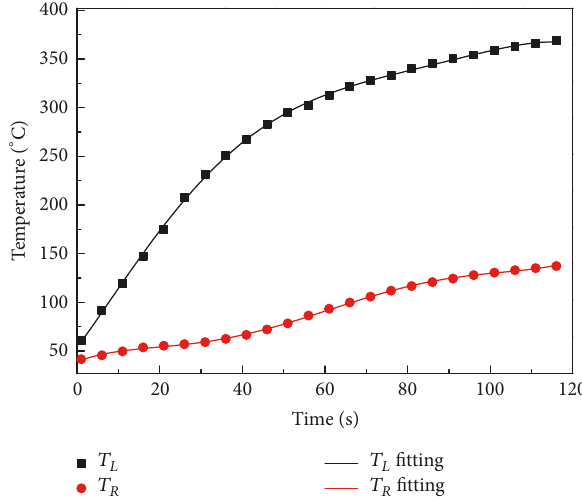
Figure 6: Temperature profiles at outer surface and back surface of fabric layer. The fitting equations for 𝑇 𝐿 and 𝑇 𝑅 are 𝑇 𝐿 = −345.713 exp (−𝑡/39.1541) + 658.2739 and 𝑇 1.64134𝑡 − 0.07761𝑡 2 − 0.07761𝑡 3 + 0.00203𝑡 4 − 1.97183 × 10 −5 + 6.46652 × 10 −8 𝑡 5 .